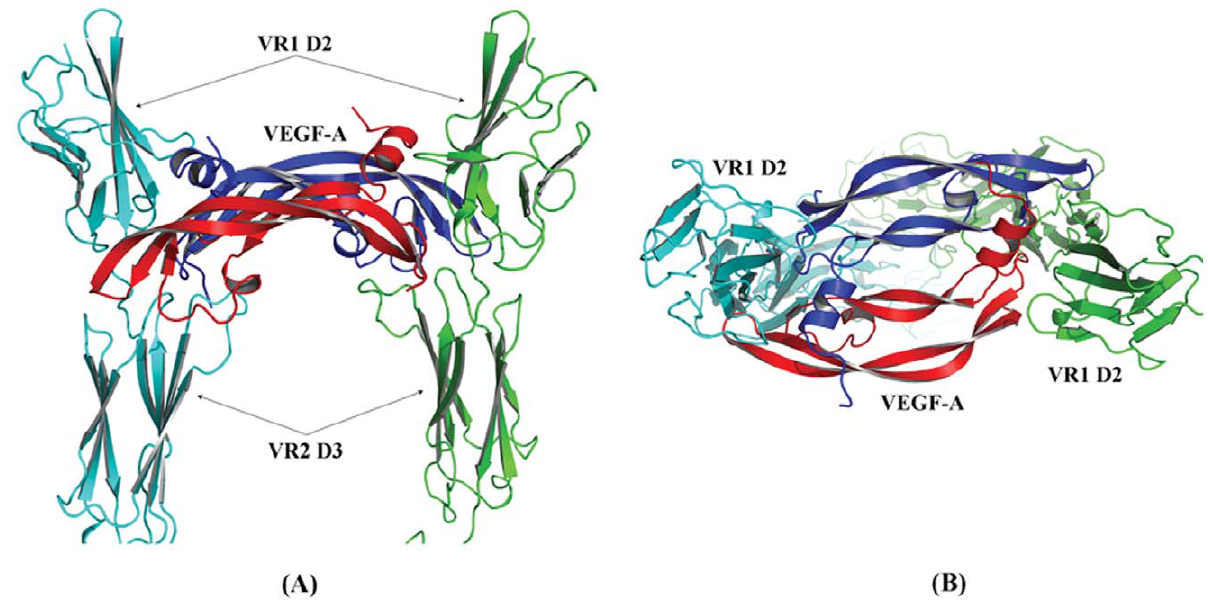
Figure 5. The MD-equilibrated structural model of the conbercept–VEGF-A functional region: (A) side-view, (B) top-view.